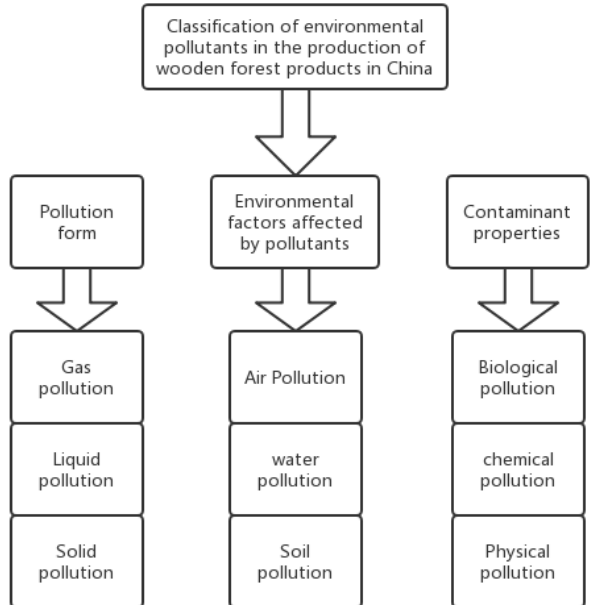
Figure 3. Classification of environmental pollutants in manufacture of wooden forest products in China.